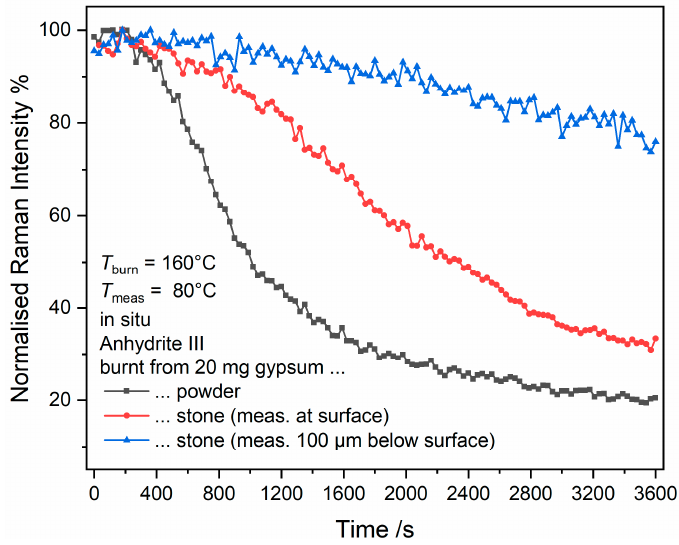
Figure 16. Decrease of relative Raman intensities during exposure of anhydrite III to ambient air at 80 °C. Anhydrite III was synthesised at 160 °C either from 20 mg gypsum powder or a stone fragment of the same mass, and, in the latter case, the measurements were performed either at the surface or within the sub-surface.